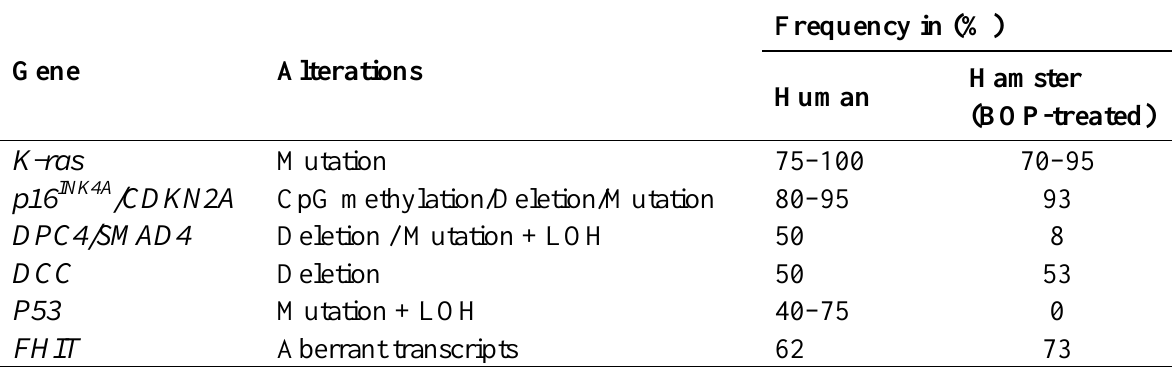
Table 1. Gene alterations in pancreatic cancers in humans and hamsters